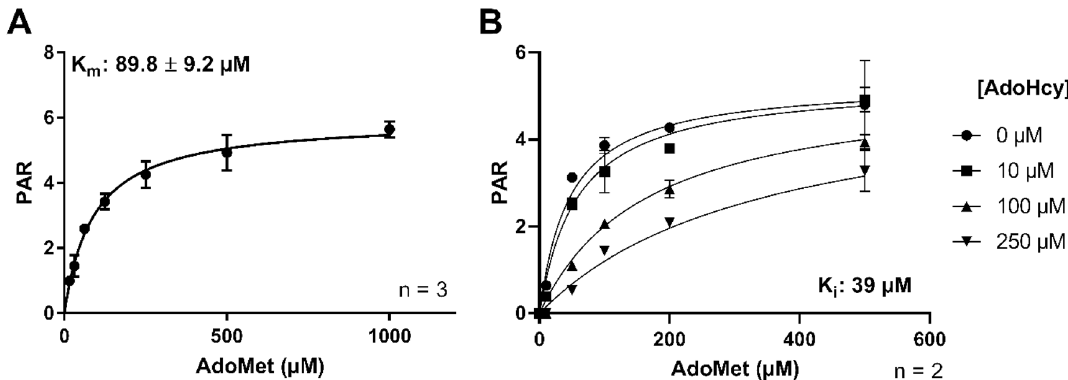
Figure 6. Captopril methylation by His-GST-METTL7B at various AdoMet concentrations in the presence or absence of AdoHcy: ( A ) His-GST-METTL7B catalyzed AdoMet-dependent methylation of captopril exhibits saturable Michaelis–Menten kinetics. Peak area ratio of methyl captopril to internal standard (PAR) versus concentration of AdoMet. ( B ) Inhibition of His-GST-METTL7B captopril methylation by AdoHcy. PAR versus AdoMet concentration curve at varying concentrations of AdoHcy. Data presented as mean ± s.d. n = 3 for ( A ) and average ± error (n = 2) for